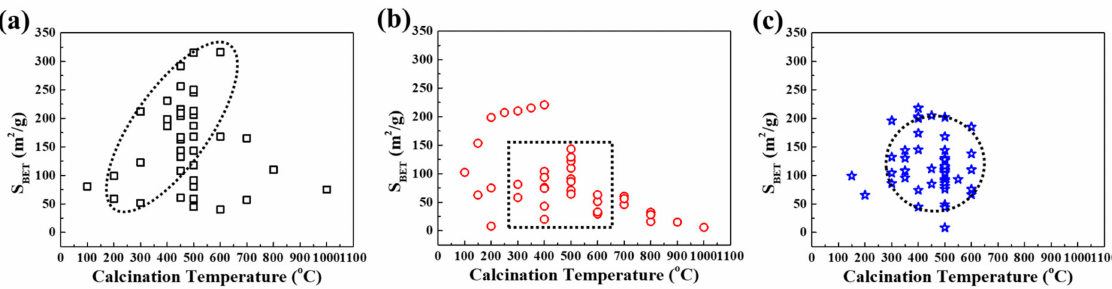
Figure 7. S BET distribution patterns by calcination temperature of ( a ) MgAl-MMO, ( b ) ZnAl-MMO, and ( c ) MgFe-MMO. Each dotted region indicates the most frequently observed S BET